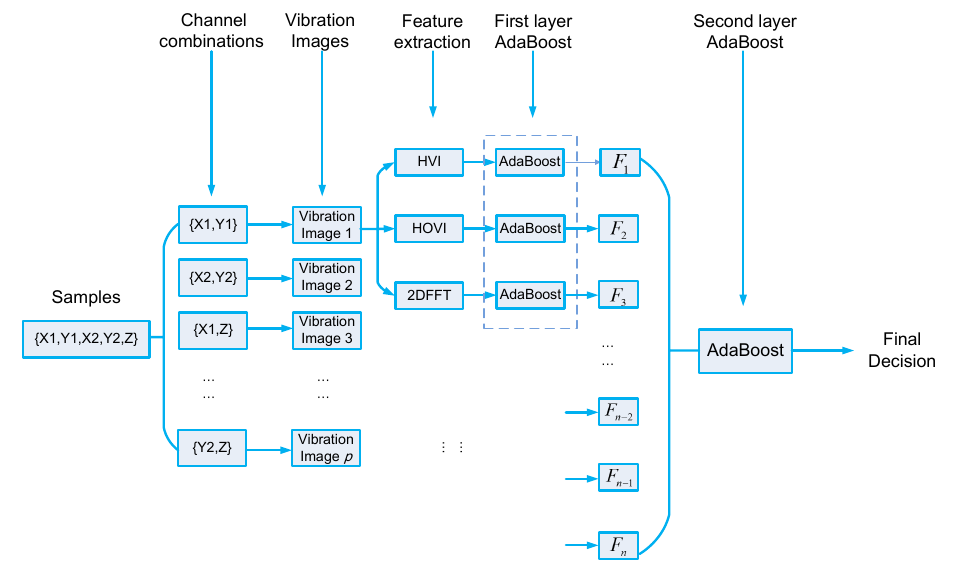
Figure 9. The detailed procedure of the proposed algorithm.